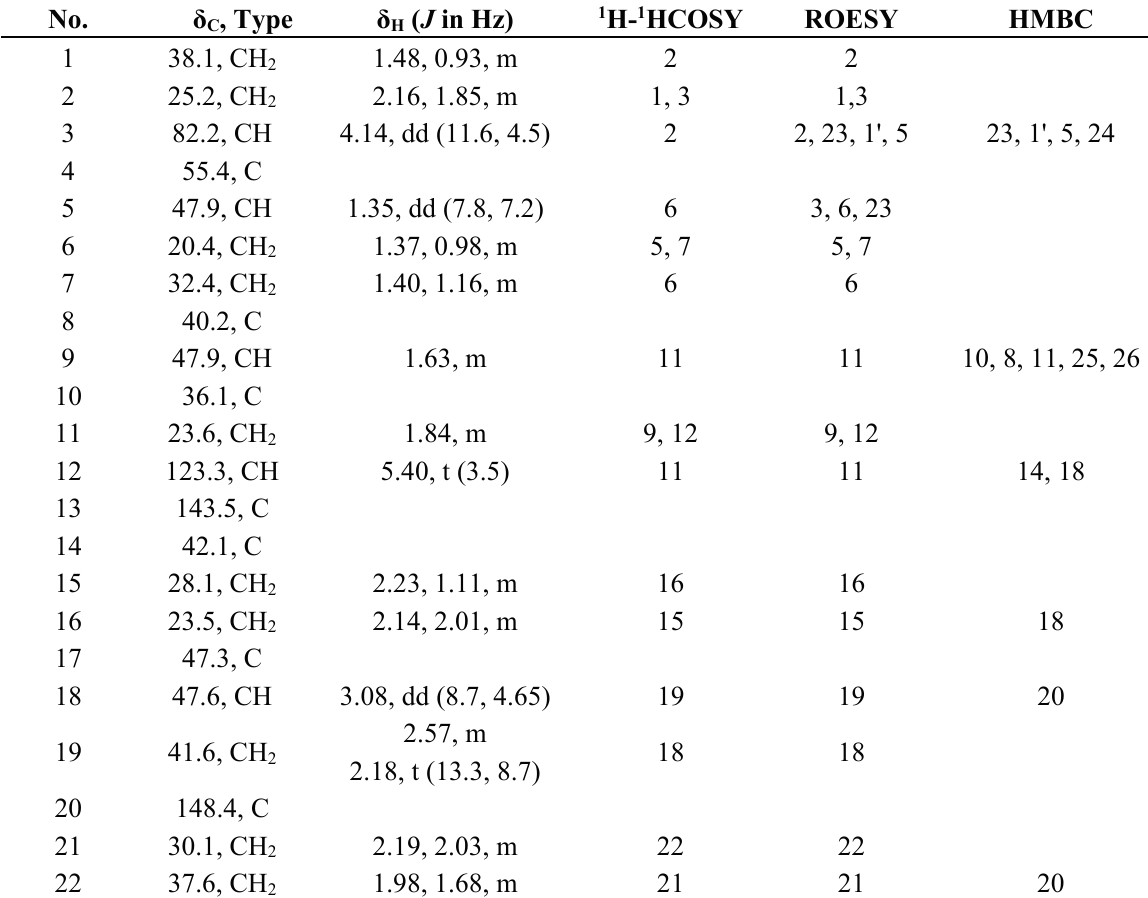
Figure 1. Negative and positive mode of ESI-MS spectra of Compound 1 . Table 1. NMR spectroscopic data for Compound 1 in pyridine- d 5 ( 1 H: 500 MHz, 13 C: 125